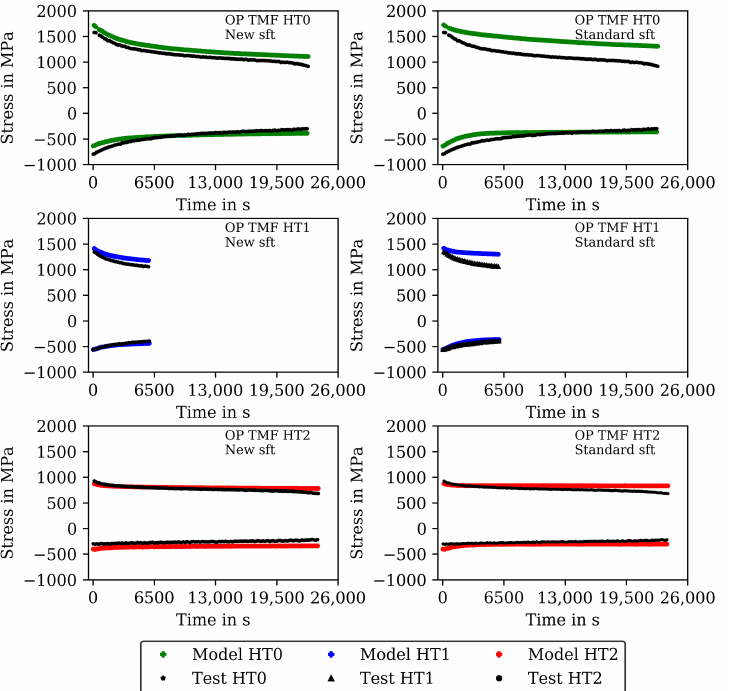
Figure 8. Stress–time diagrams for the measured stress and stress calculated with the viscoplasticity model for the out-of-phase TMF tests for the HT0, HT1, and HT2 material at the points of strain reversal (mechanical strain amplitude of 0.01). New isotropic-softening model ( left ) and standard isotropic-softening model ( right ). Incomplete data for HT1 due to interrupted data